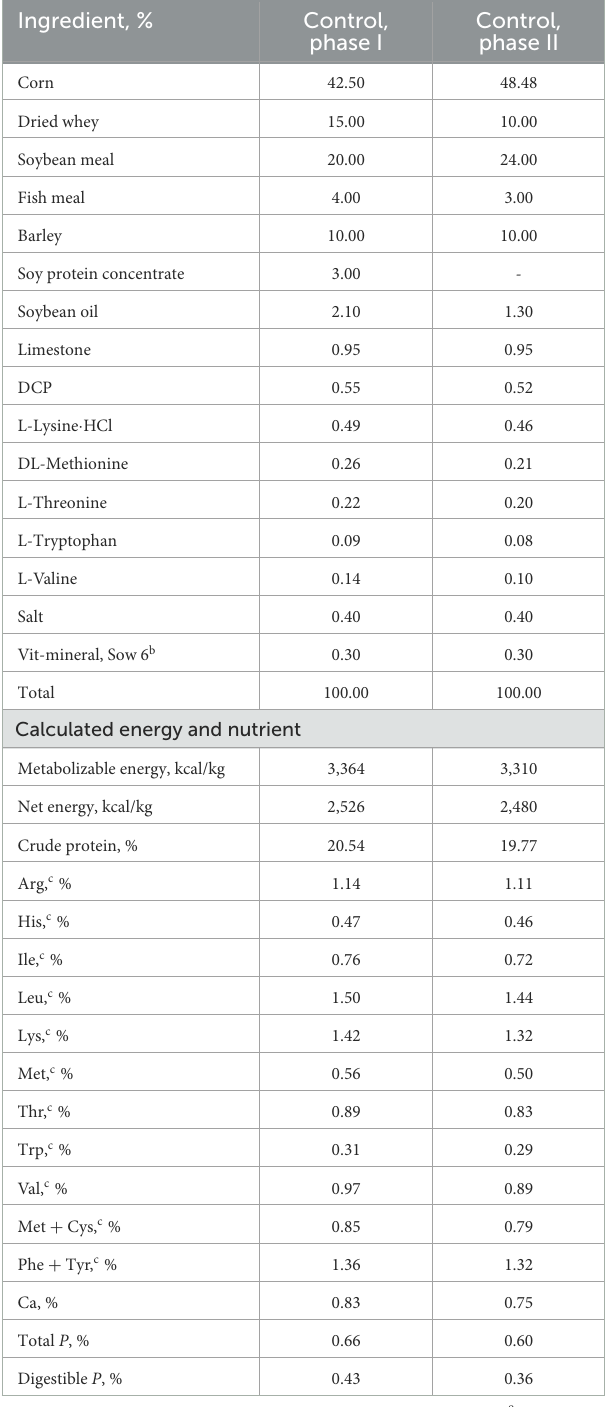
TABLE 1 Ingredient compositions of experimental diets, as fed basis a